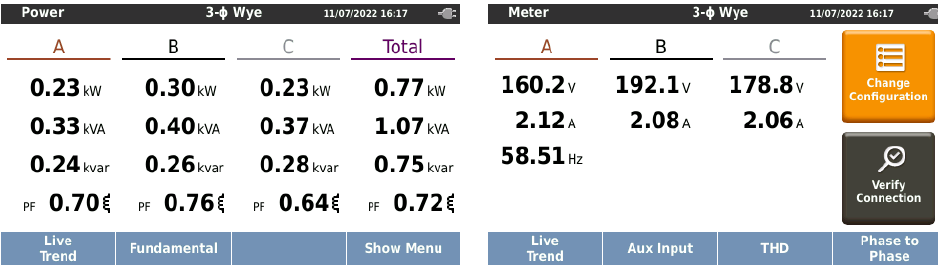
Figure 17. Real-time active power, power factor, voltage, and current using data logger.